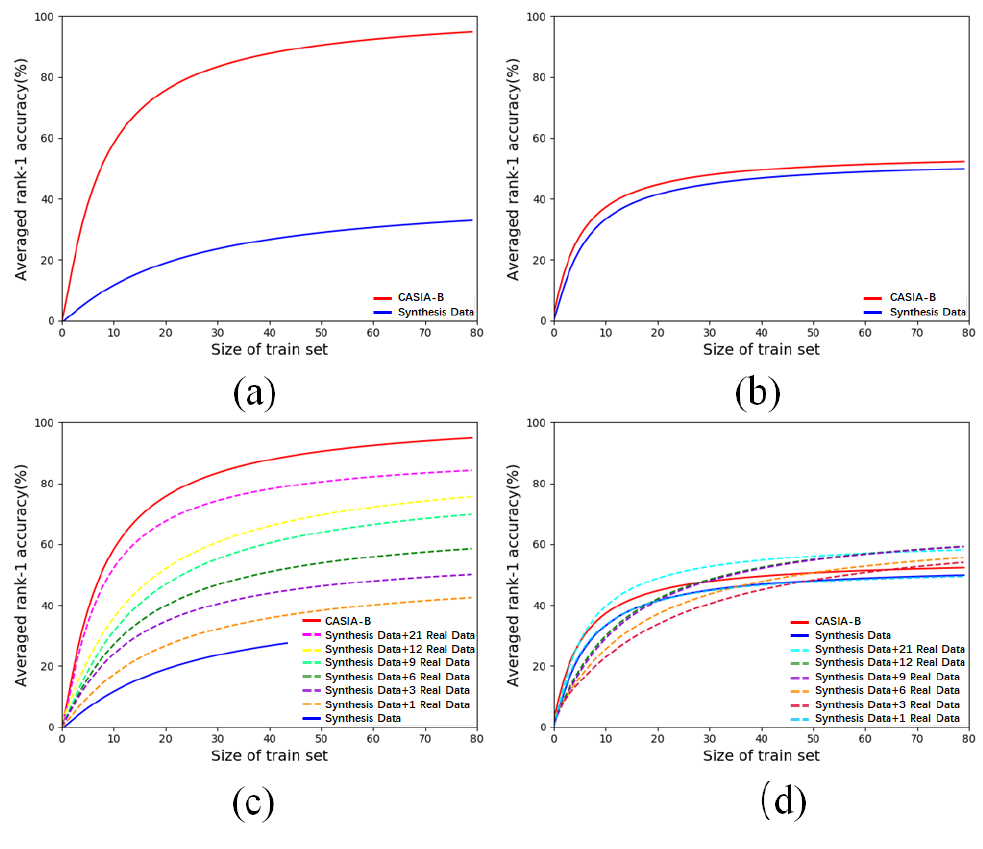
Figure 8. Performance gap and closing: the first row plots curves of accuracy against training set size for the CASIA-B test set ( a ) and OU-MVLP test set ( b ); the second row shows accuracy curves with real data added in the training of the synthetic model for the CASIA-B test set ( c ) and OU-MVLP test set ( d